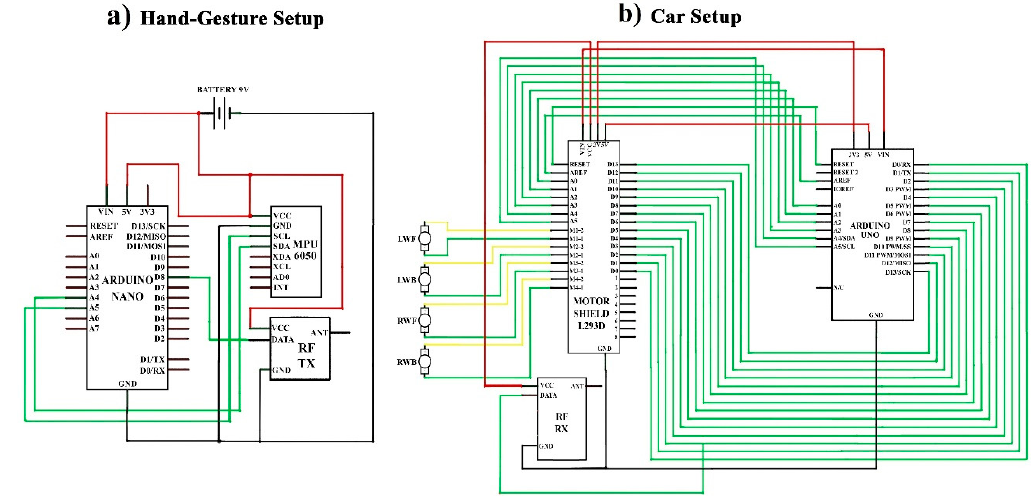
Figure 2. Circuit design of the car controlling system using hand gestures recognition. ( a ) Shows the schematic of the hand-gesture setup. ( b ) Displays the schematic design of car